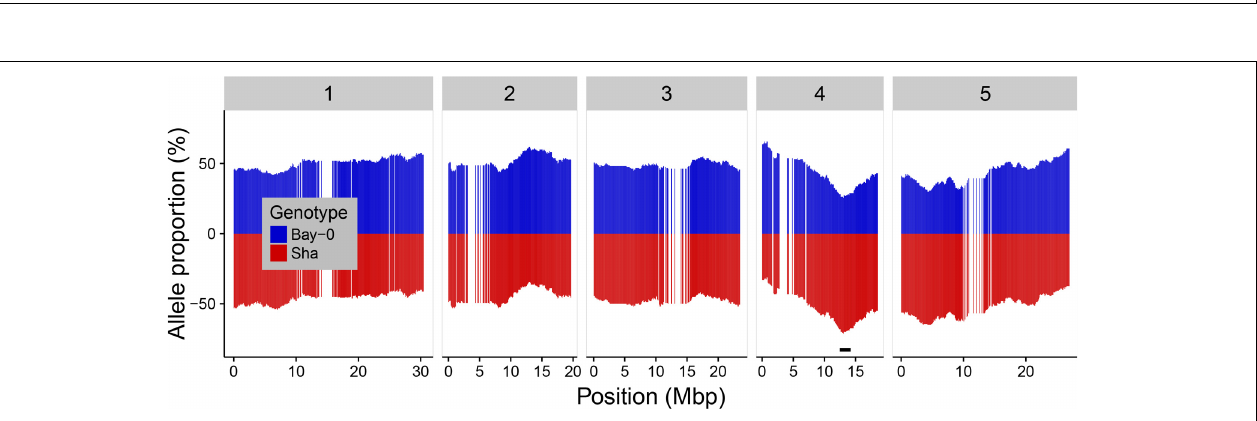
FIGURE 2 | Allele distribution for the 1059 markers along the five chromosomes. Blue and red colors indicated the Bay-0 and the Sha allele percentages, respectively. The black horizontal bar indicates the region on chromosome 4 with 29 markers showing significant segregation distortion ( p -value < 0.05 after Bonferroni correction).